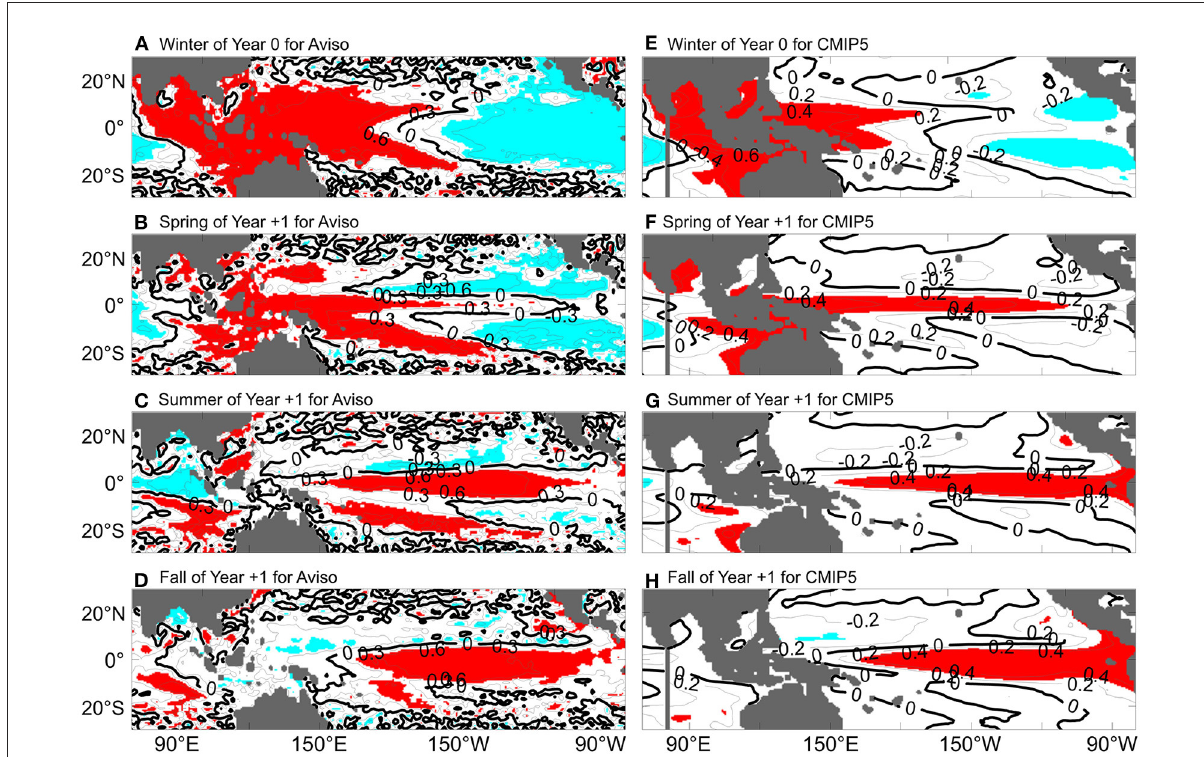
FIGURE5 Lag correlations between the STIO SSHA in the fall of Year 0 and the tropical Indo-Pacific SSHA from the winter of Year 0 through the fall of Year + 1 during positive phases. (A–D) Aviso. (E–H) cross-model averaged from CMIP5 historical simulations. The red and blue shading indicate the 95% significance level of positive and negative correlations,